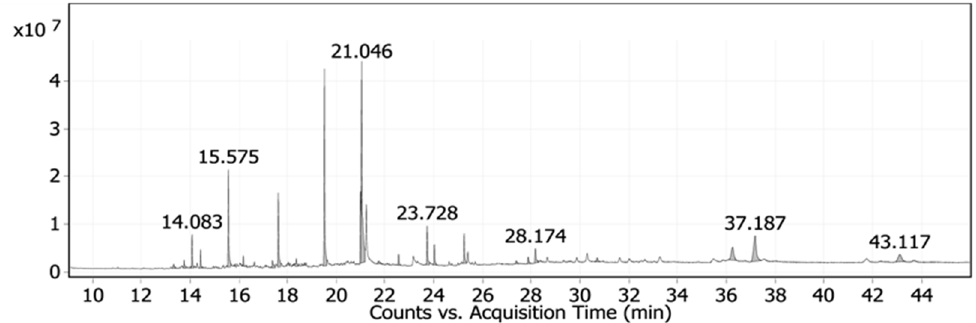
Figure 1. GC-MS chromatogram of DPPE showing the peaks for various components.